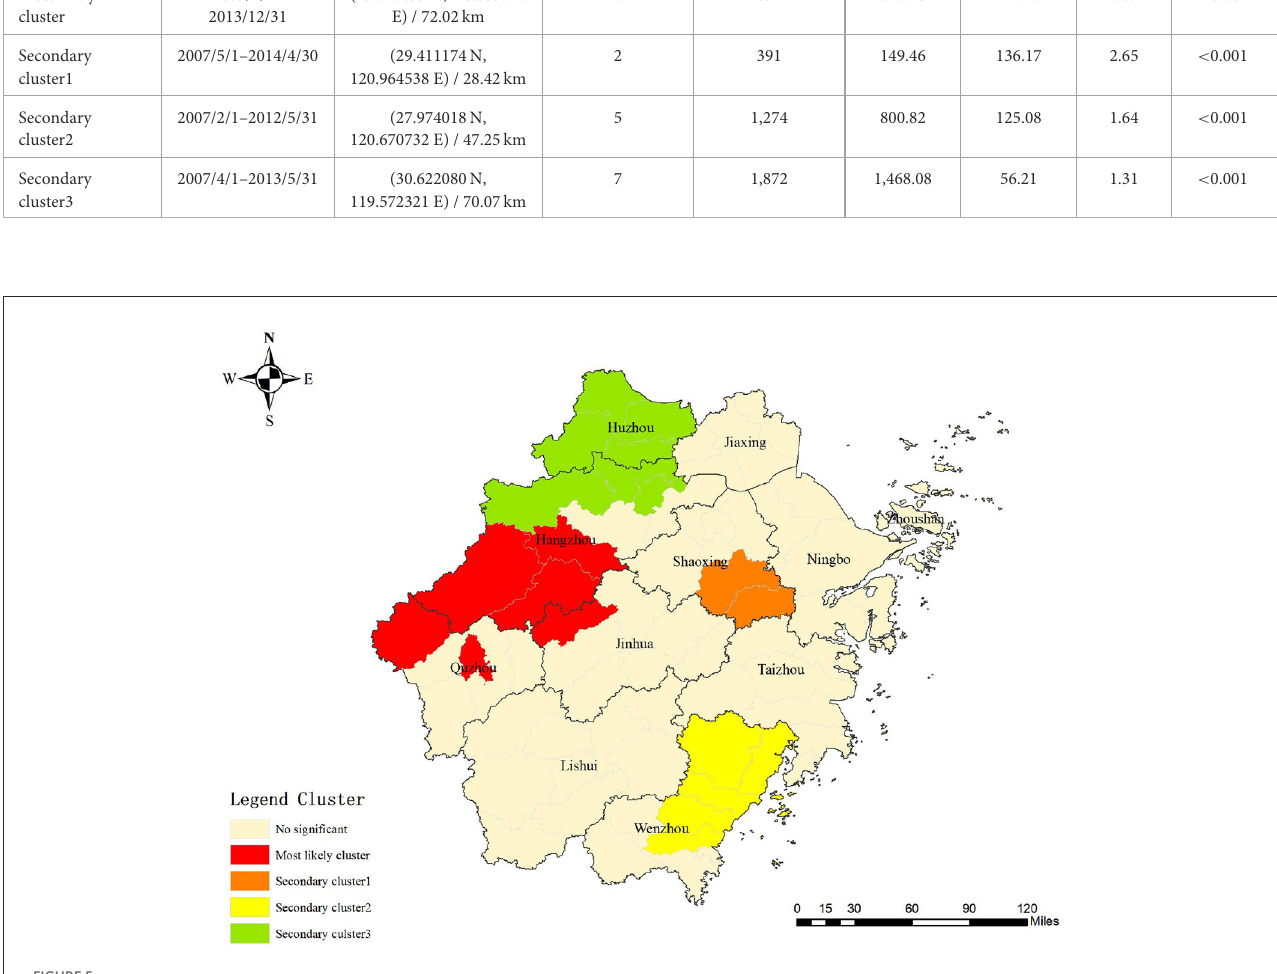
FIGURE5 Spatial-temporal clustering result of notified PTB among students in Zhejiang